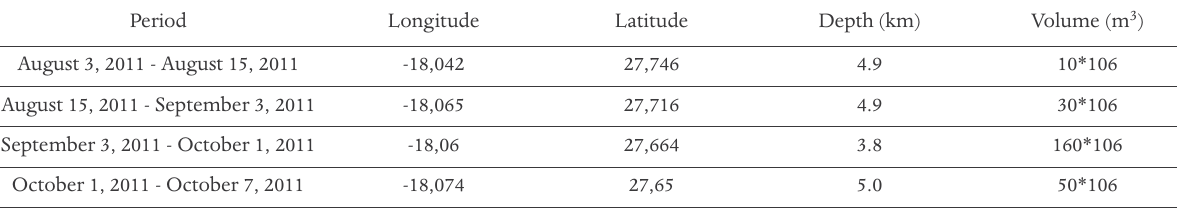
Table 1. Position (latitude, longitude and depth) of deformation sources and volume calculated according to Mogi [1958]